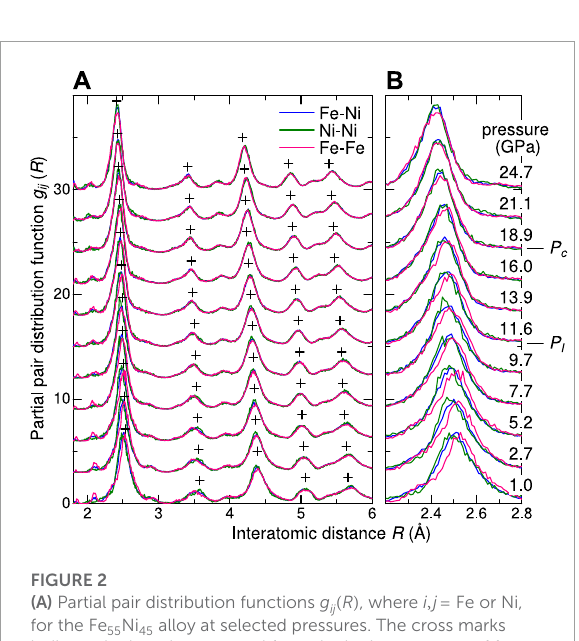
FIGURE 2 (A) Partial pair distribution functions g ij ( R ) , where i , j = Fe or Ni, for the Fe 55 Ni 45 alloy at selected pressures. The cross marks indicate the lengths expected from the lattice constant of fcc structure. (B) Enlarged plot of g ij ( R ) around the first nearest neighboring Fe-Fe and Fe-Ni and Ni-Ni atomic